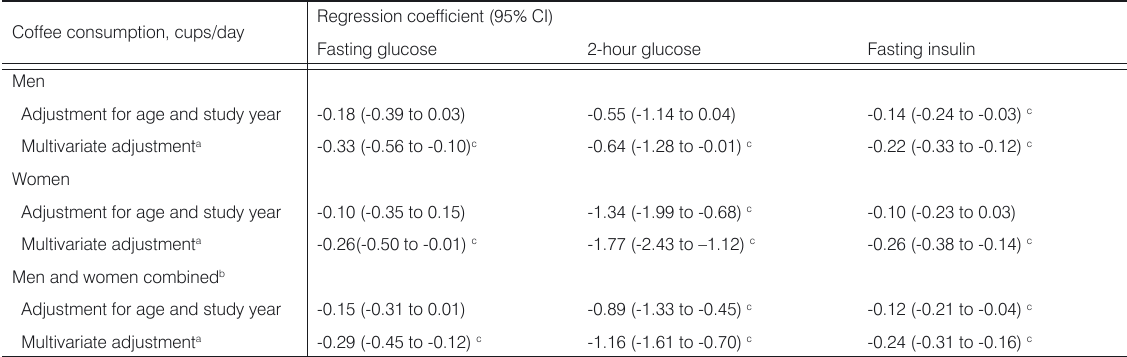
a Adjusted for age, study year, body mass index, systolic blood pressure, education, occupational and leisure time physical activity, walking or cycling to/from work, cigarette smoking, alcohol and tea consumption. b Adjusted also for sex. c P value